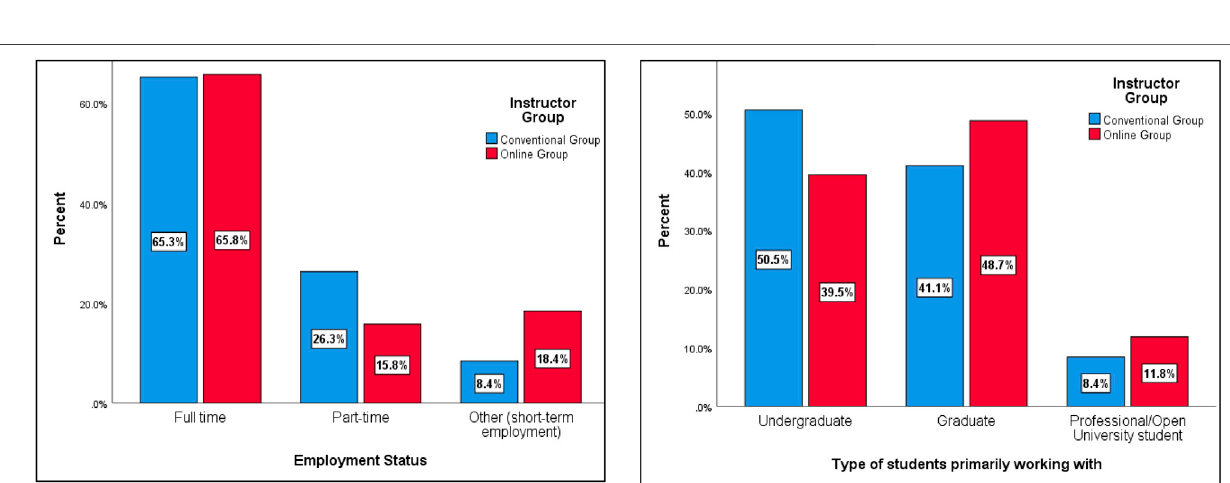
FIGURE 1 | Distribution of age ( Figure 1-left ), and teaching experience (in years) in a higher/adult education institution ( Figure 1-right ), for the OnlineGroup and the Conventional Group.